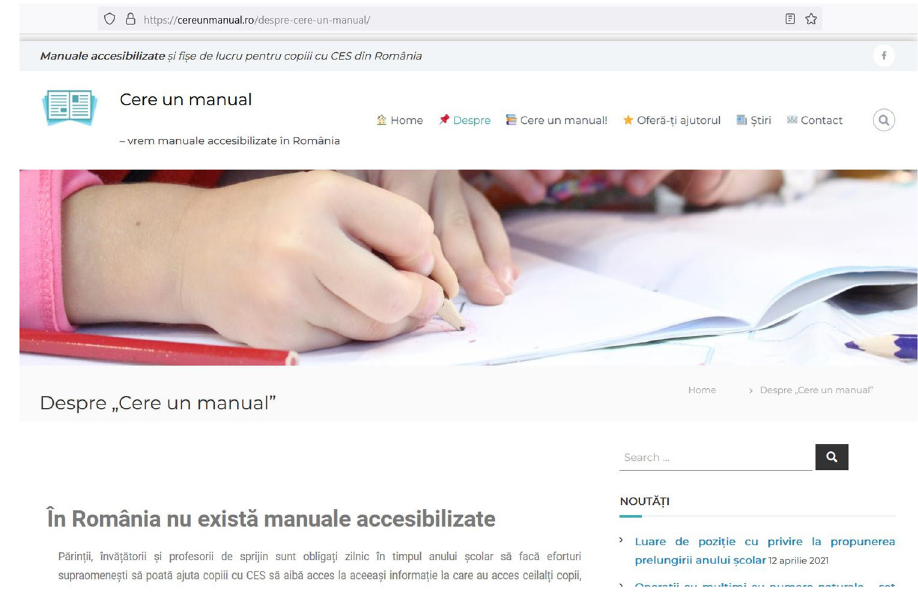
Figure 3: Cere un manual [ Ask for a textbook ] website.